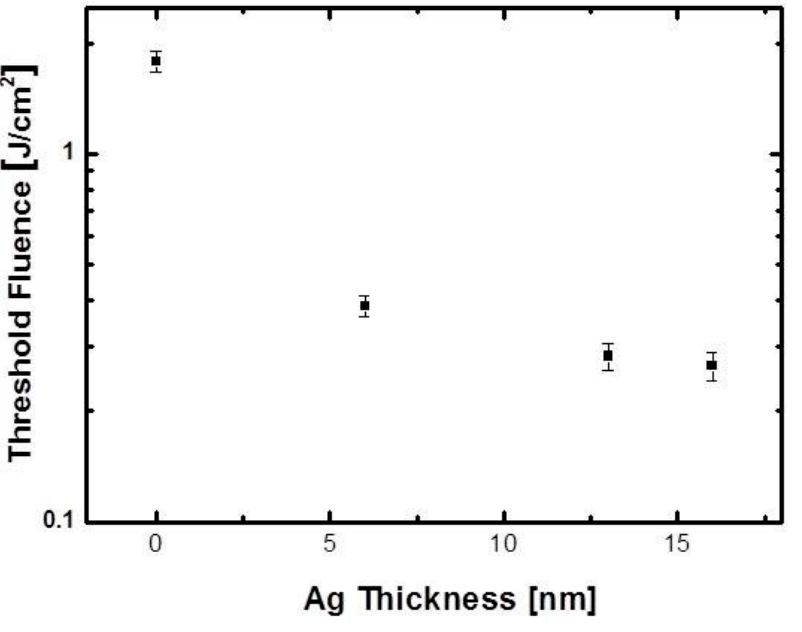
Figure 3. Laser direct ablation thresholds of ITO/Ag/ITO MLs with different Ag thicknesses. Figure 4 shows the scanning electron microscopy (SEM) images of laser-ablated ITO/Ag/ITO MLs with different Ag thicknesses at a constant scanning speed of 500 mm/s and laser pulse energy of 67 µ J. As shown in Figure 4a, the ablated line width was approxi- mately 58 µ m for the ITO SL. For the ITO/Ag/ITO MLs with Ag thicknesses of 6, 13, and 16 nm, similar ablated line widths of 73–74 µ m were measured, as shown in Figure 4b–d, respectively. Although the ITO/Ag/ITO MLs showed a wider ablation line width than the ITO SL without the inserted Ag mid-layer, the Ag thickness did not affect the laser-ablated line width, despite the different optical transmittances and absorption